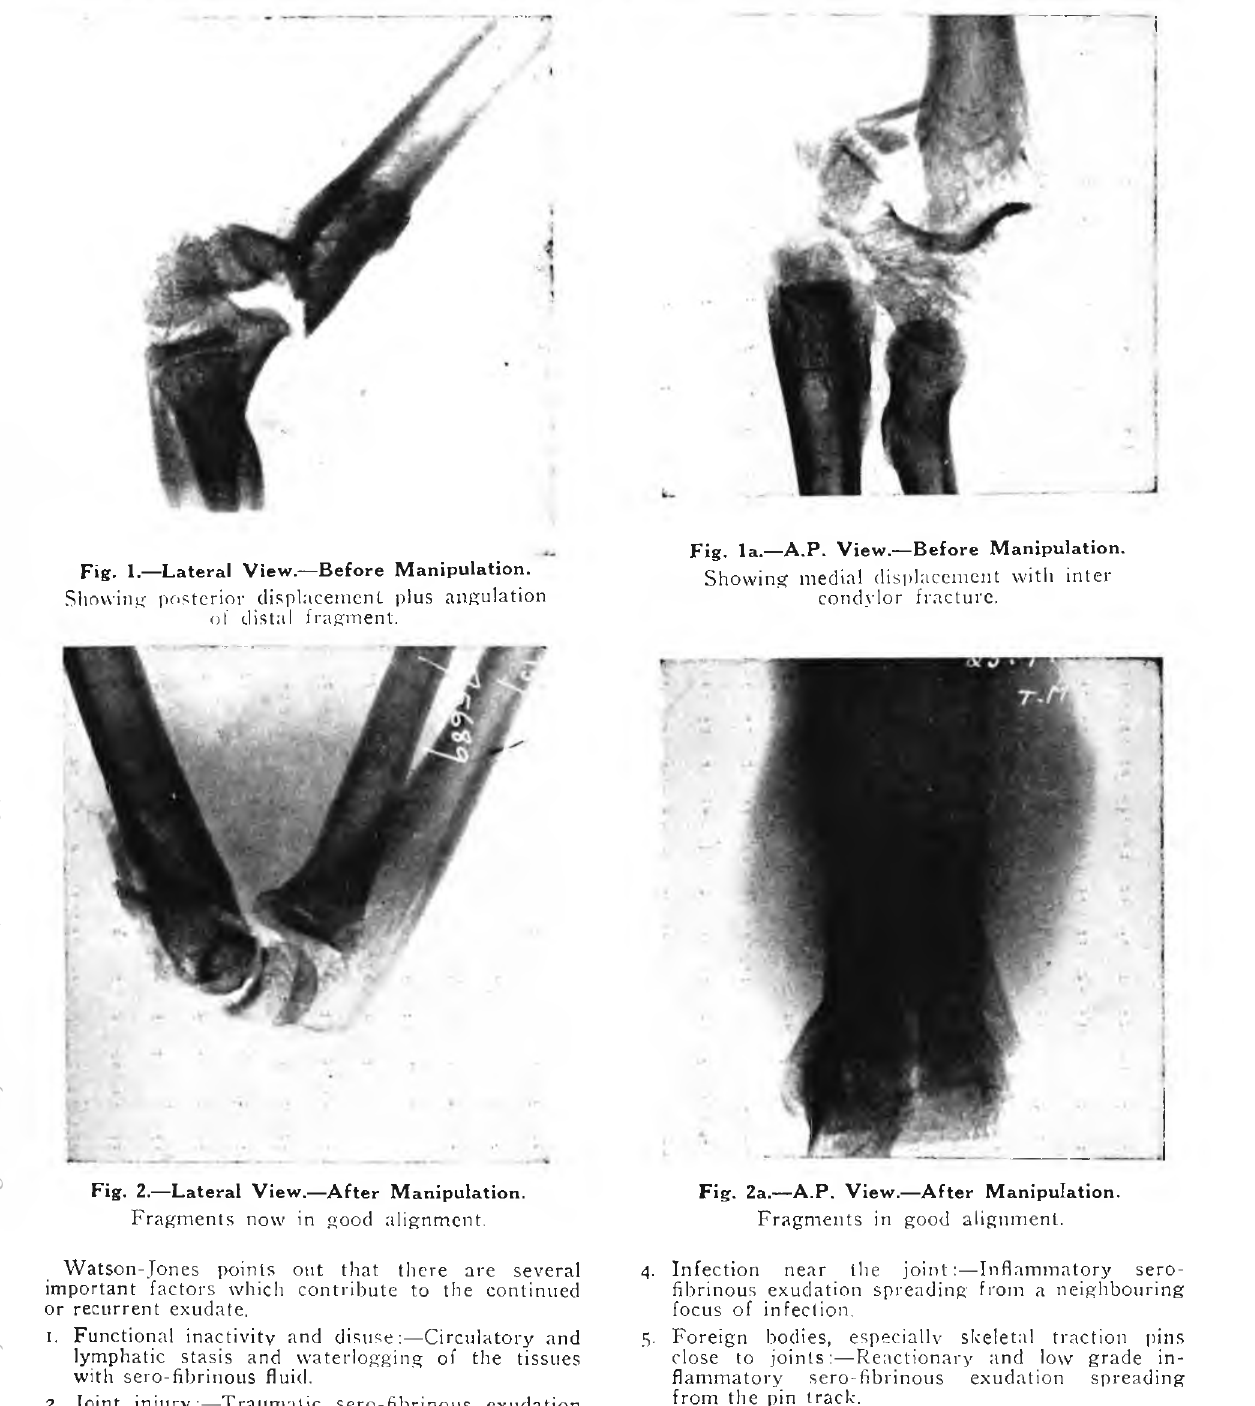
Fig. 2.— Lateral View .—A fter M anipulation. Fig. 2a.— A .P. V iew .— A fter M anipulation.